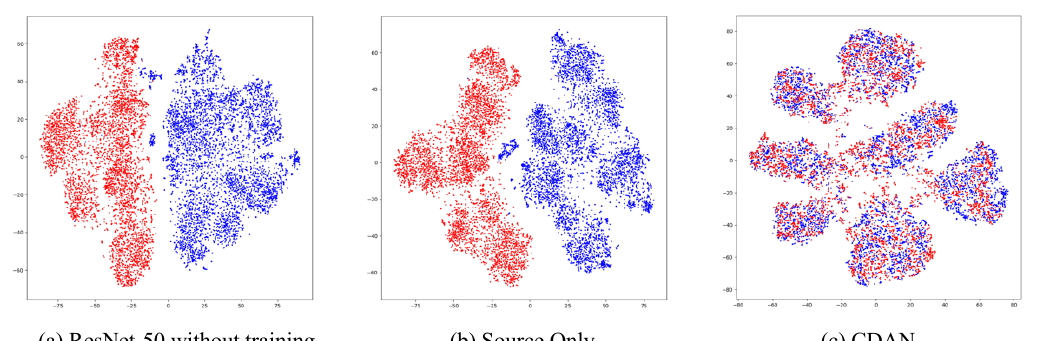
Figure 5 . The t-SNE visualizations of (a) ResNet-50 without training, (b) Source Only and (c) CDAN, where blues points indicate